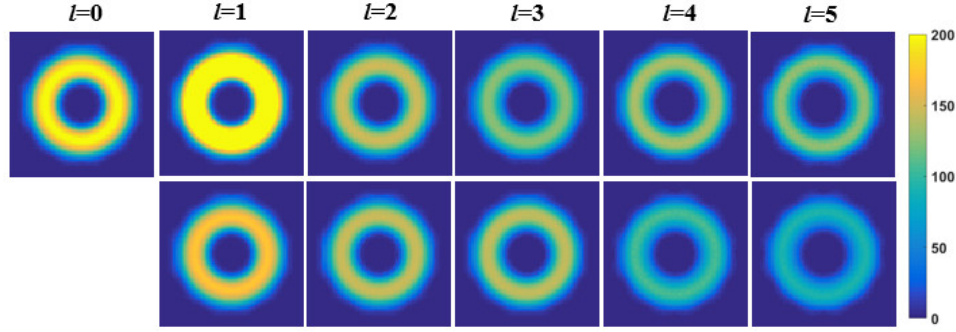
Figure 5. The electric field intensity distribution of the OAM mode in the terahertz OAM PCF.